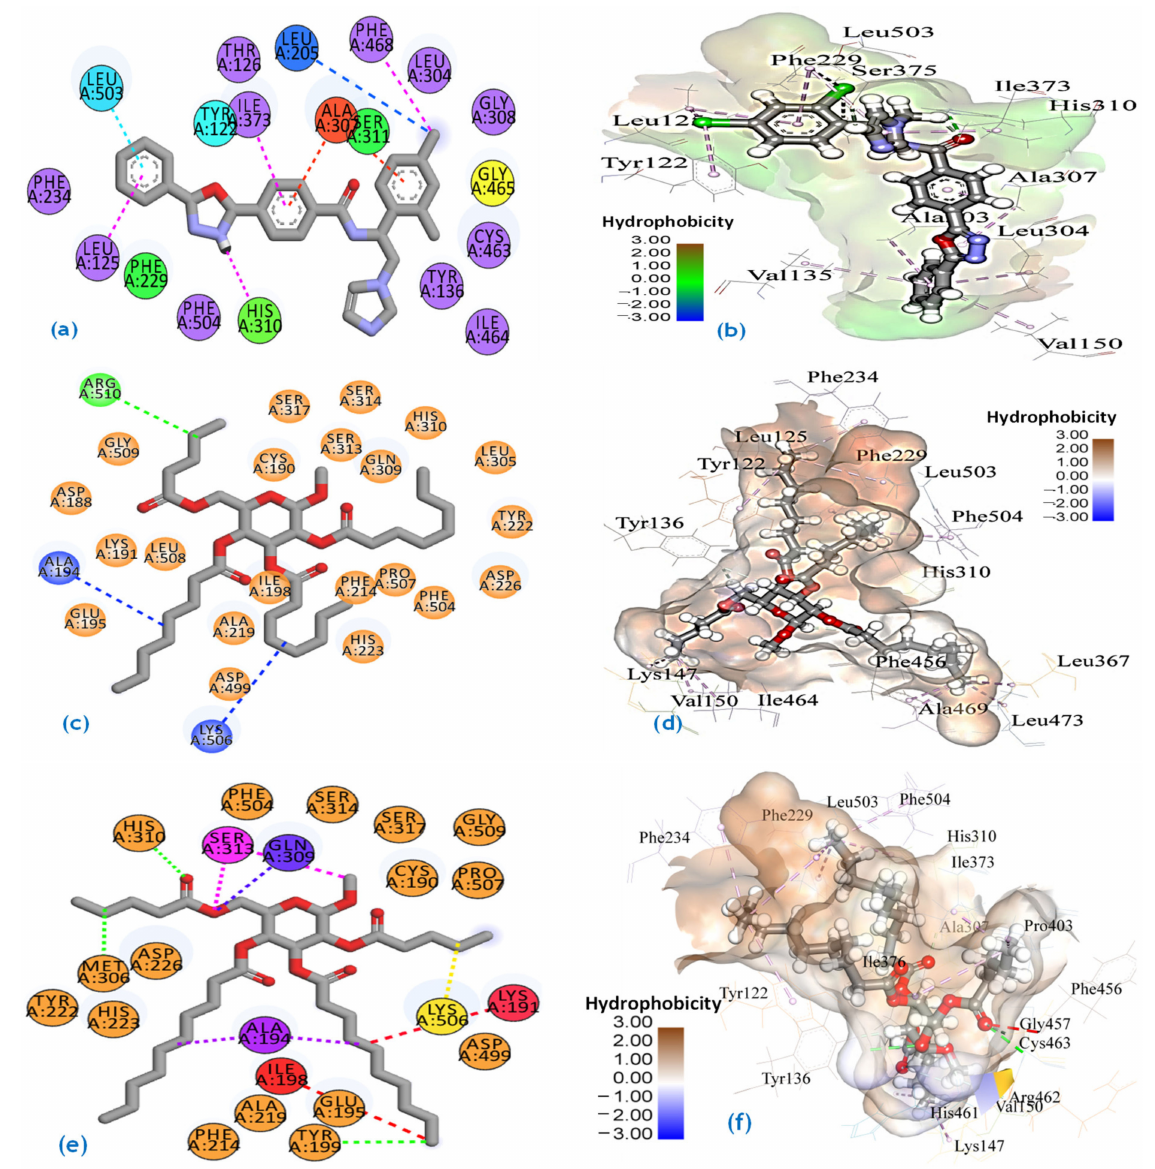
Figure 5. Binding modes of compounds with sterol 14 α -demethylase. ( a , b ) VNI and sterol 14 α - demethylase complex; ( c , d ) compound 8 and sterol 14 α -demethylase complex; ( e , f ) compound 12 and sterol 14 α -demethylase